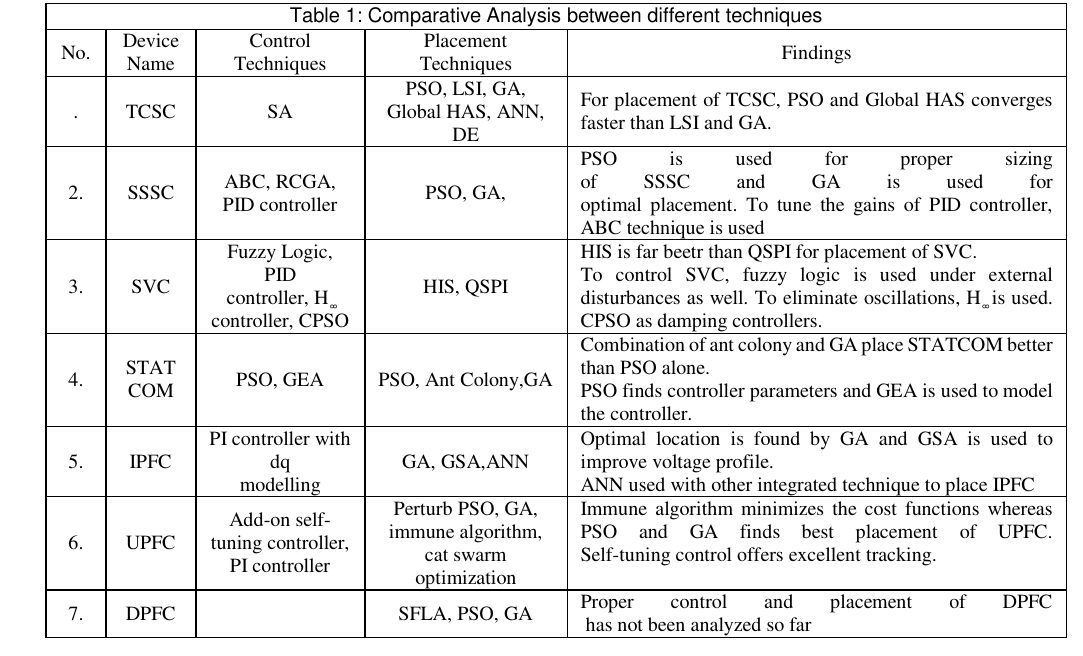
Table 1: Comparative Analysis between different